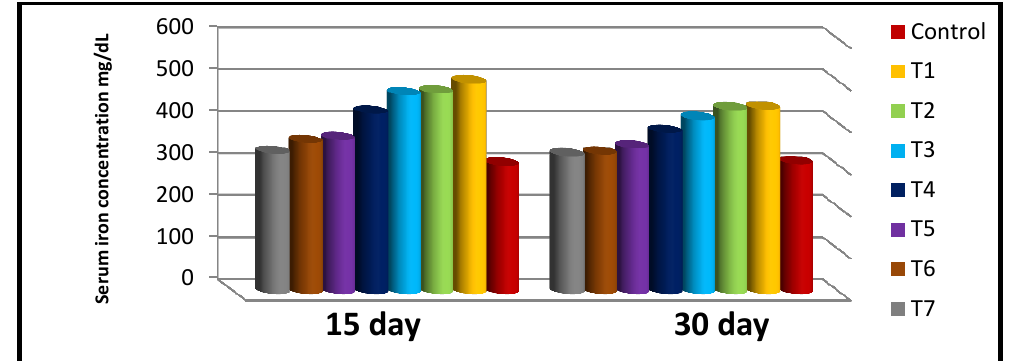
Figure 1: Effect of different doses of total polyphenol extracted from green tea for 15 and 30 days on serum iron concentration (mg/dL) of iron overload treated rats.